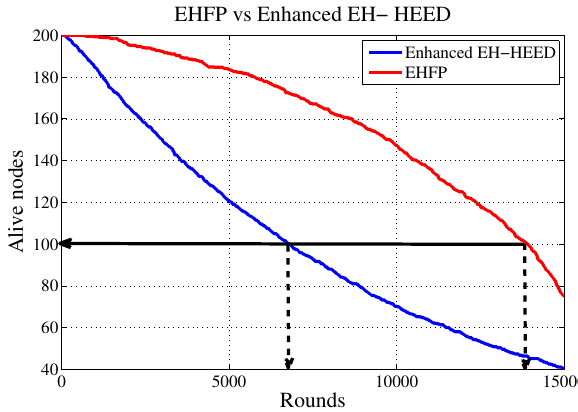
Figure 14. Life-time comparison of our proposed EHFP clustering vs enhanced EH-HEED with EH up-till 40 nodes alive